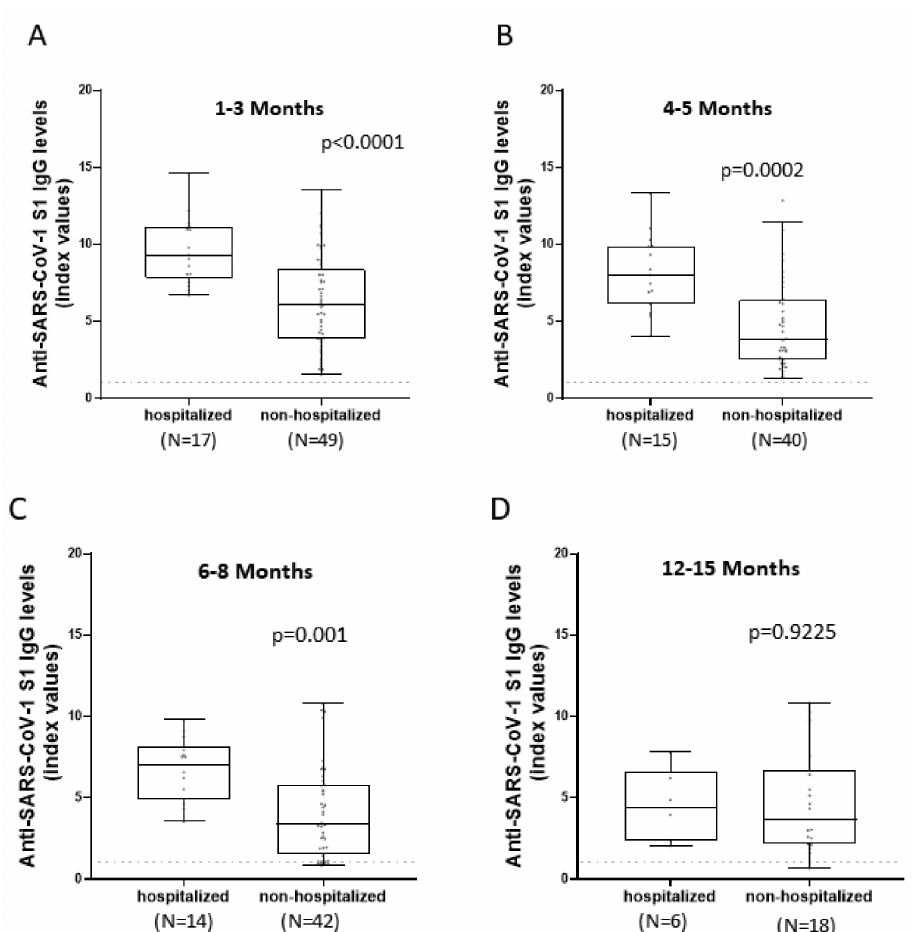
Figure 3. Comparison of IgG responses targeting SARS-CoV-2 S1 between hospitalized and non- hospitalized patients in various time-points. Hospitalized and non-hospitalized IgG responses were measured at various time-points as different groups. Statistical analysis occurred between hospitalized and non-hospitalized patients, regardless of their sex, and Unpaired t -test ( A ) and Mann– Whitney test ( B – D ) were used to determine whether there was a significant difference between the antibody titers of the two groups at a certain time-point each time. Horizontal dashed lines represent the cut-off value of the assay used. Comparison of anti-SARS-CoV-2 IgG titers between hospitalized and non-hospitalized patients ( A ): In samples collected one to three months after infection. ( B ): In samples collected four to five months after infection. ( C ): In samples collected six to eight months after infection. ( D ): In samples collected twelve to fifteen months after